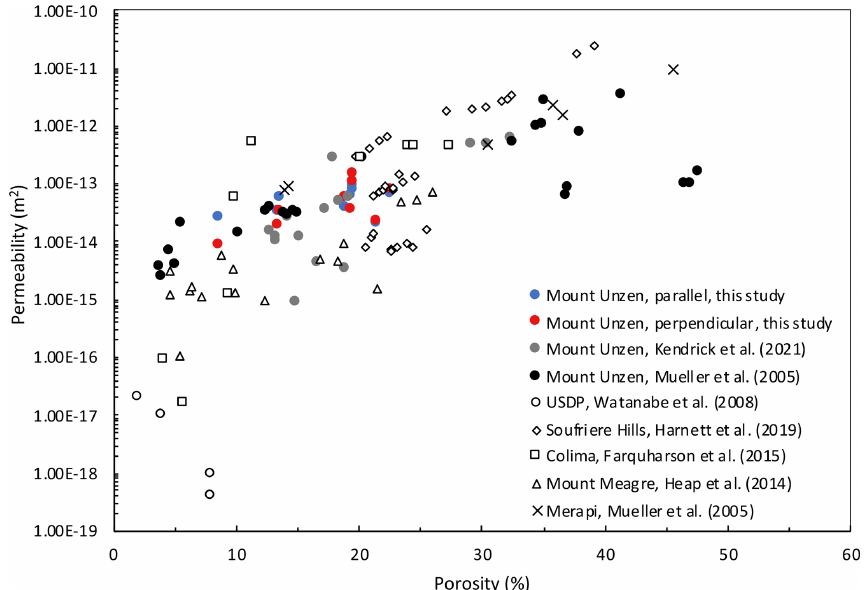
Figure 8. Permeability–porosity relationship for Unzen dome lavas and other volcanic products. Blue and red circles represent data from this study, made parallel and perpendicular to the plane of shear, respectively. Grey circles show porosity data for Unzen from Mueller et al. (2005) and Kendrick et al. (2021), and open circles show permeability measurement on USDP drill cores from Watanabe et al. (2008). Other symbols indicate porosity–permeability measurements for volcanic materials from Soufriere Hills volcano (Harnett et al., 2019), Volcán de Colima (Farquharson et al., 2015), Mount Meagre (Heap et al., 2014), and Merapi volcano (Mueller et al.,